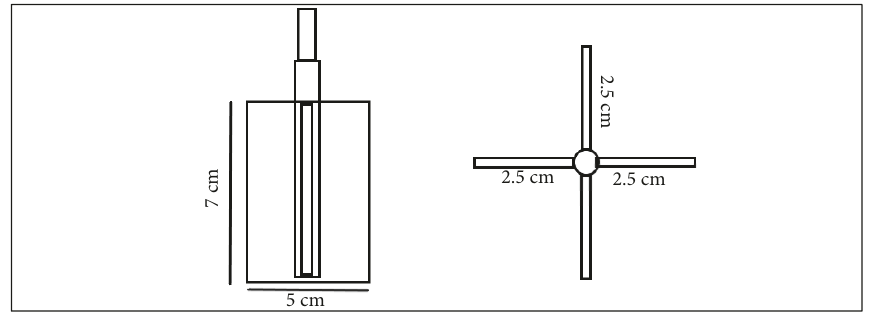
Figure 1: Vane shear